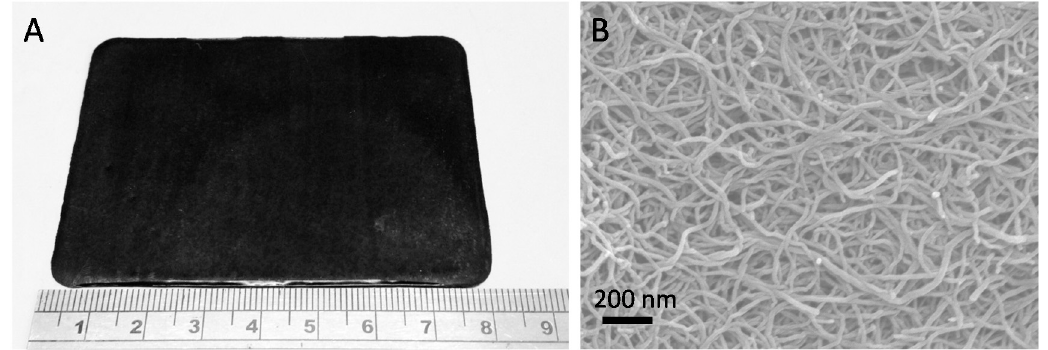
Figure 5. ( A ) Digital photograph of a MWNT buckypaper; ( B ) an SEM micrograph of a MWNT buckypaper (BP).